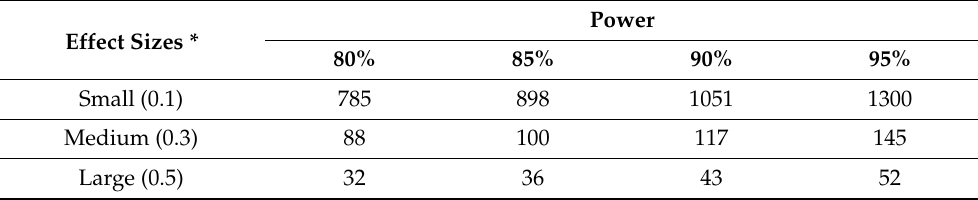
Table 2. Sample size requirements for the chi-squared test for association for different effect sizes and powers, in case-control studies (df = 1) for a level of significance equal to 0.05. Power Effect Sizes * 80% 85% 90% 95% Small (0.1) 785 898 1051 1300 Medium (0.3) 88 100 117 145 Large (0.5) 32 36 43